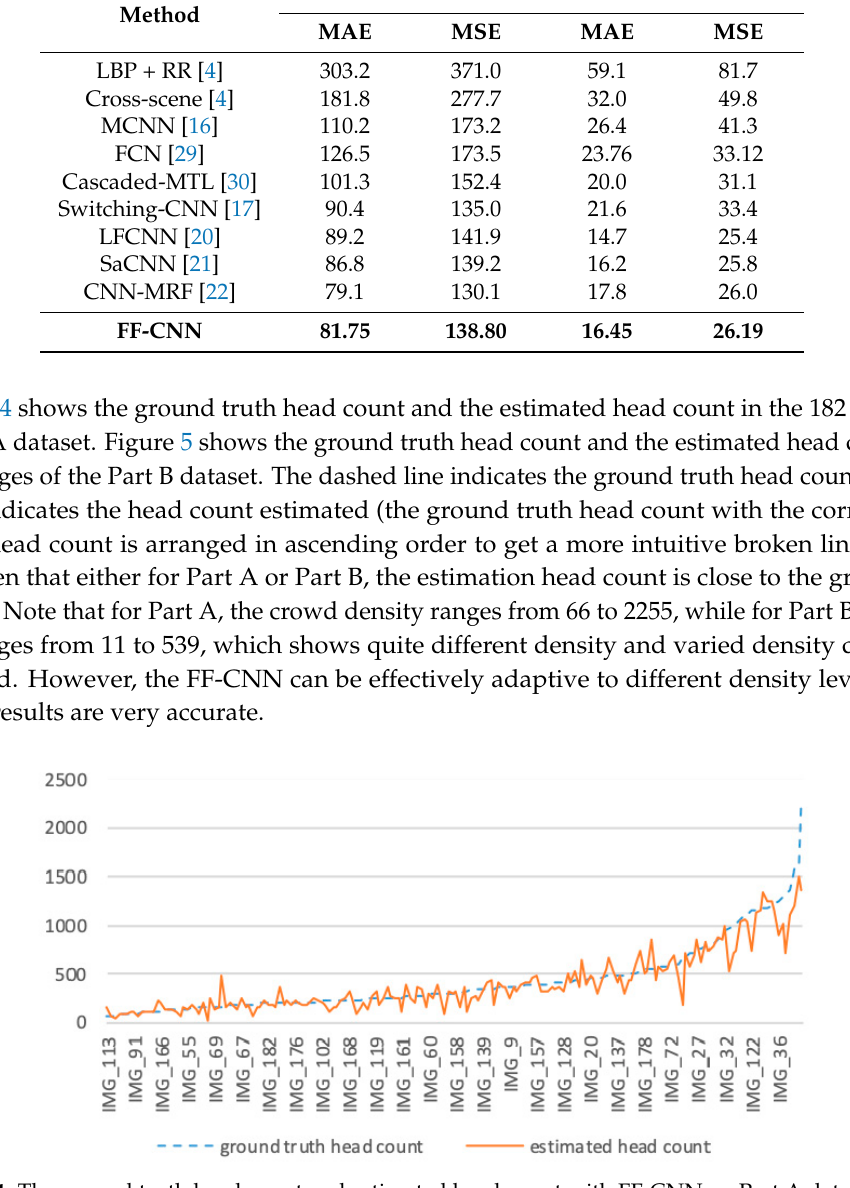
Figure 4. The ground truth head count and estimated head count with FF-CNN on Part A dataset (the vertical axis represents the head counts, and the horizontal axis represents the test sample).